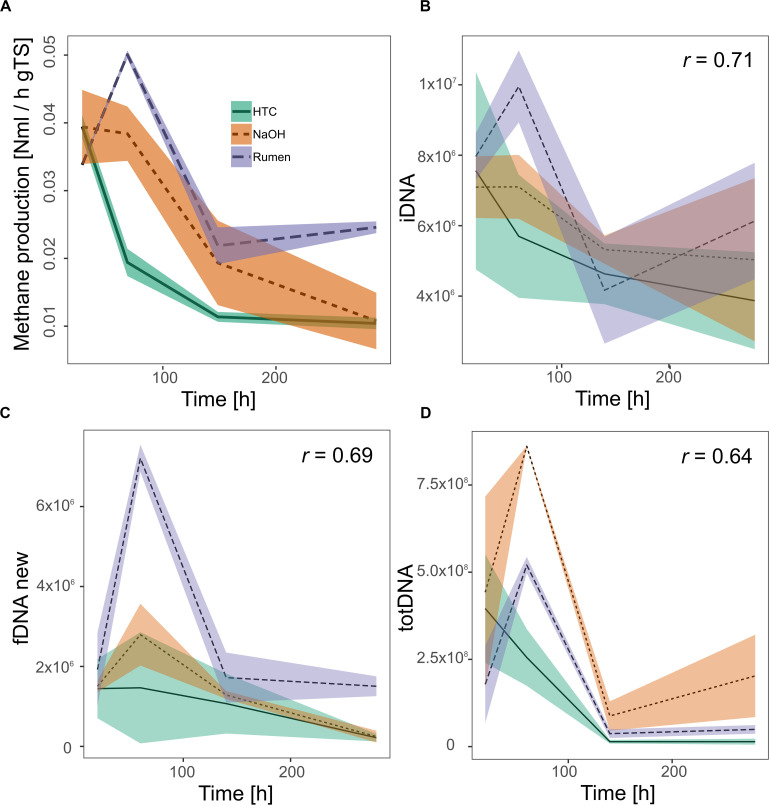
Activity of methanogenic archaea as measured by their methane production rates (A) and as approximated quantifying mcrA gene copies (gene copies gFW– 1) within (B) iDNA, (C) fDNAnew, and (D) totDNA. All significant Pearson correlation coefficients (r, p < 0.01) of the approximations with the methane production rates are given in the respective graphs. Lines represent mean values, shaded areas the standard deviation (n = 3).